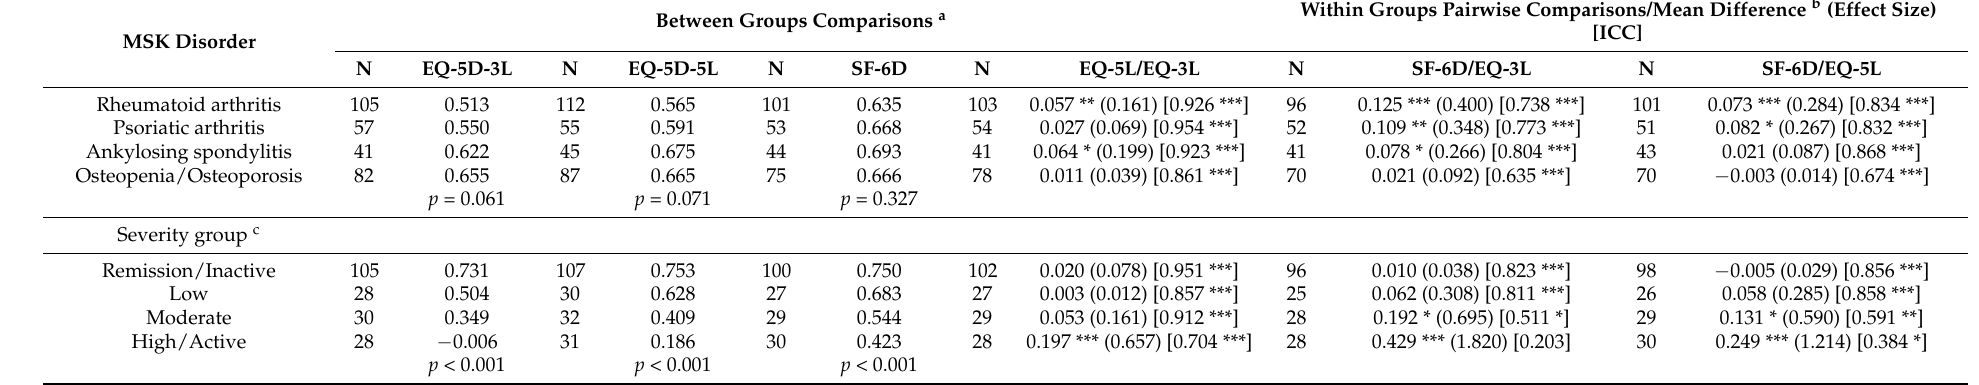
Table 3. Comparison of utility scores between and within MSK disorder and severity